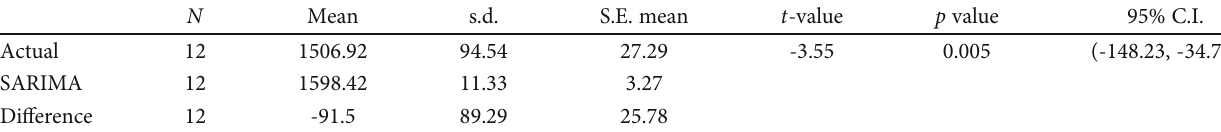
Table 7: Paired sample t -test results: actual versus SARIMA forecast of 2018 demand.